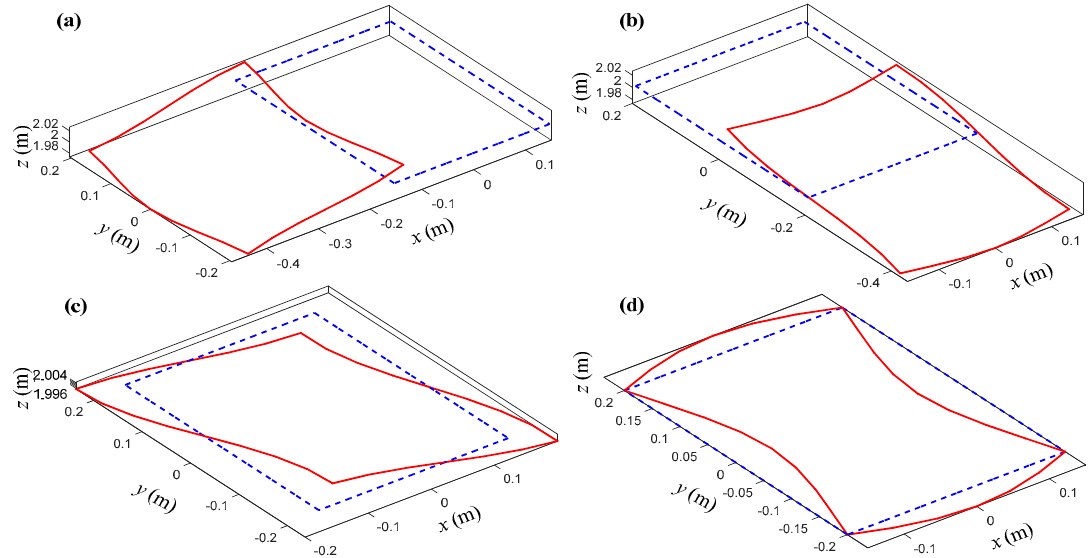
Figure 5. Deformed cross-sections of the free end for the first four modal shapes of the thin-walled structure with a rectangular hollow cross-section: ( a ) The 1st modal, ( b ) the 2rd modal, ( c ) the 3rd modal, and ( d ) the 4th modal.